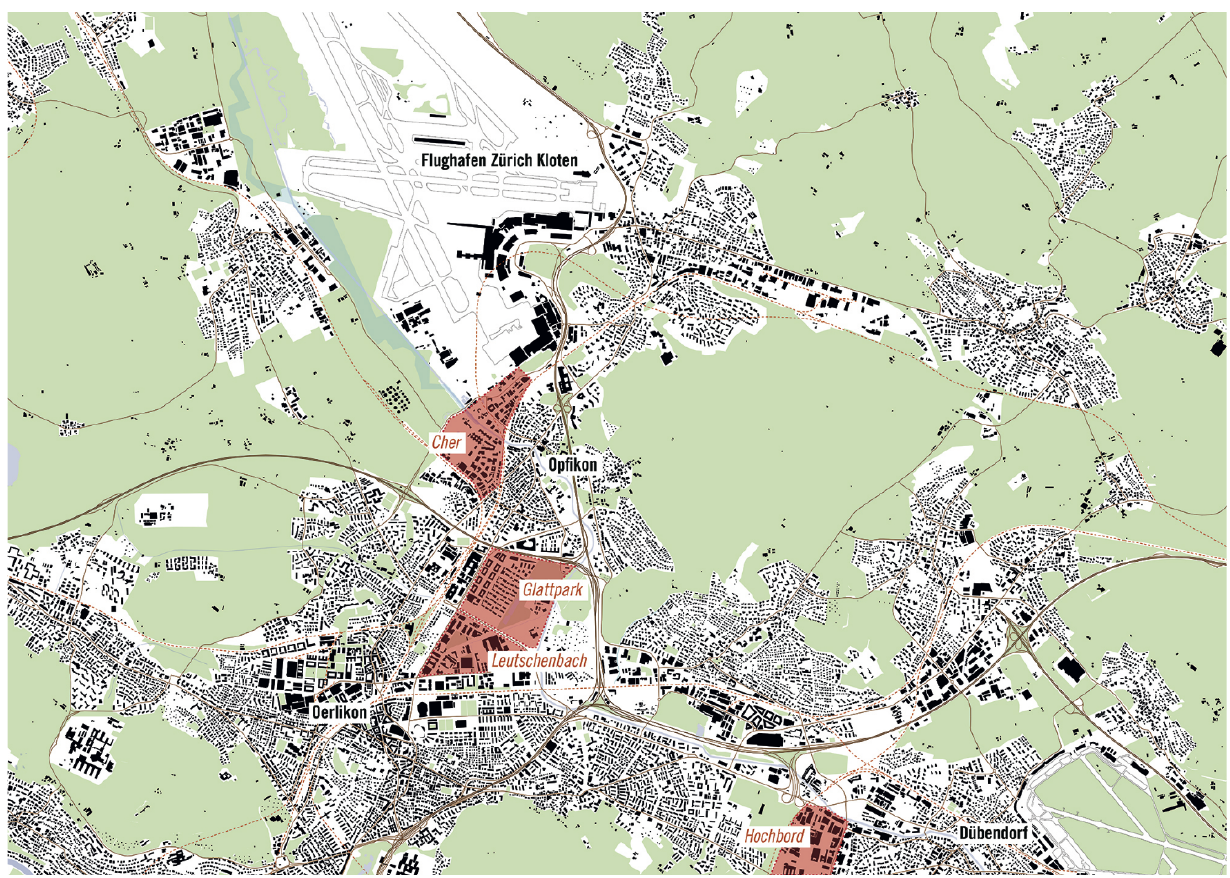
Figure 2. Building structure and infrastructural connections in the Zürich-Nord/Glatttal Region with suburban office loca- tions Cher, Glattpark, Leutschenbach und Hochbord. Source: author based on Kretz & Küng,